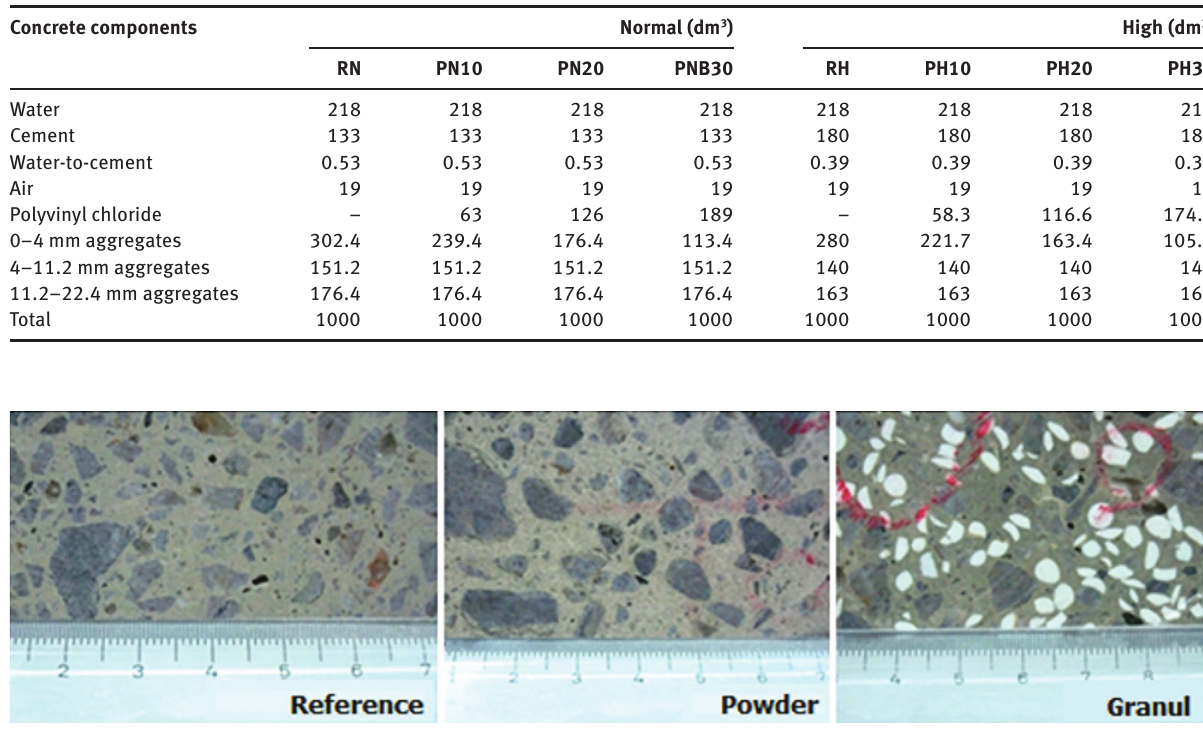
Table 4 Concrete mixtures of 1 m 3 .